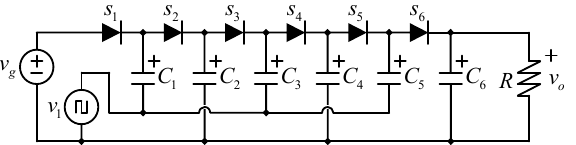
Figure 6. A reduced version of the converter shown in Figure 4 [18].